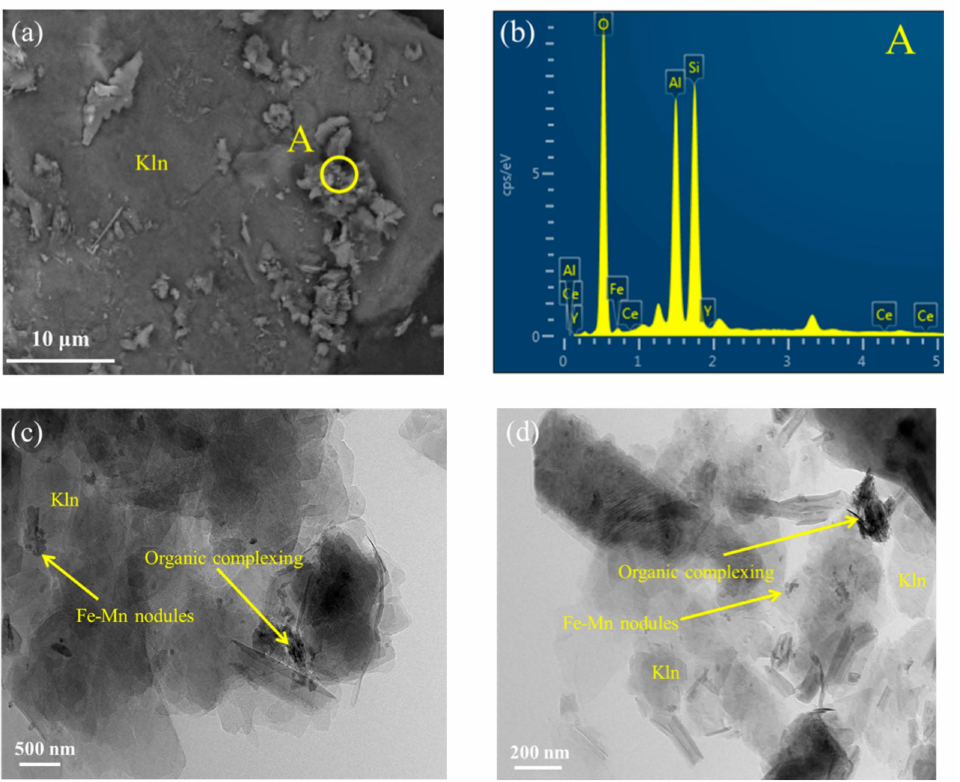
Figure 11. Microstructure characteristics of rare earth organic binding state, Kln = kaolinite. ( a ) Surface microstructure of organic binding state of rare earth ores; ( b ) Results of energy spec- trum analysis at point A; ( c , d ) Transmission electron microscopy analysis of organic binding state of rare earth ores.